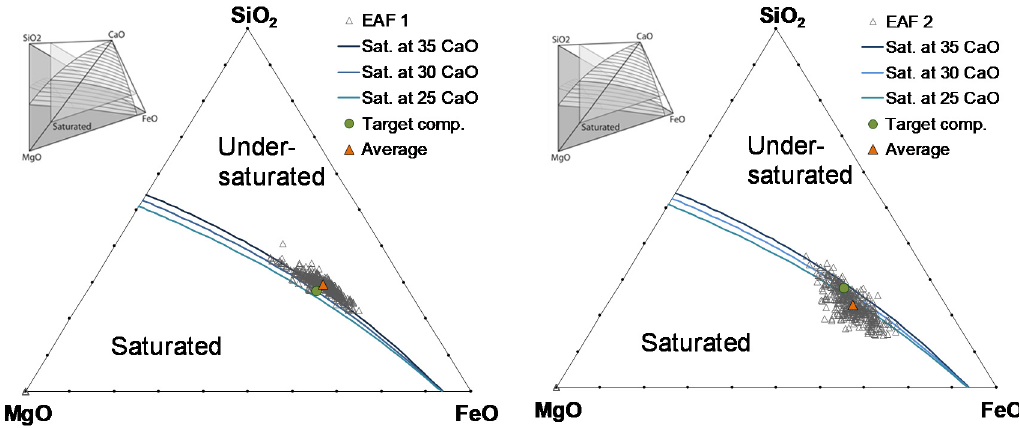
Figure 4. Distribution of slag analysis data from EAF heats for carbon steelmaking, in the system CaO–SiO 2 –FeO–MgO– 5%Al 2 O 3 ; lines indicate MgO saturation at 25% to 35% CaO and 1600 °C.